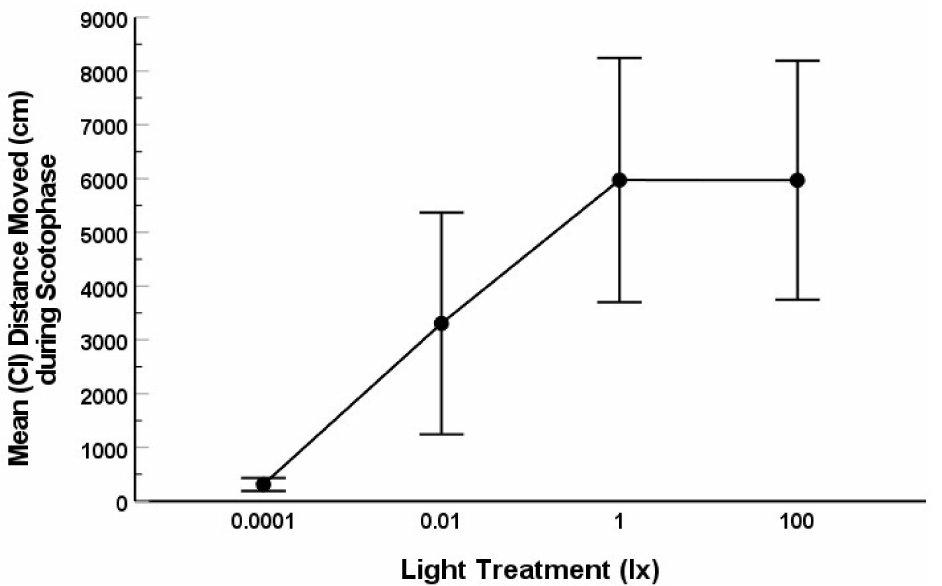
Figure 4. Mean (and CI) total distance moved (cm) by fruit flies from the time lights went off (clock hour 1800 h) until lights on (clock hour 0600 h) for each lighting treatment: 0.0001, 0.01, 1, or 100 lx ambient nocturnal lighting. The error bars represent 95% CI. Different letters represent treatments that were significantly different.